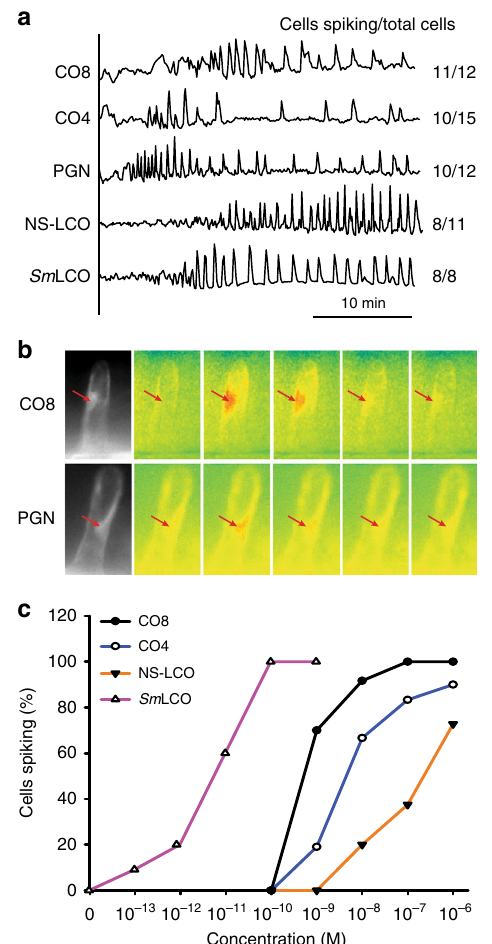
Fig. 1 COs and LCOs activate symbiotic calcium oscillations. a Representative traces of 10 − 8 M CO8, 10 − 8 M CO4, 0.8 mg/ml PGN, 10 − 8 M NS-LCO and 10 − 9 M Sm LCO-induced calcium oscillations in M. truncatula trichoblasts on lateral roots. The y -axis represents the ratio of YFP to CFP in arbitrary units. Numbers denote responsive cells relative to total cells analysed. b CO8 and PGN-induced calcium oscillations were restricted to the nuclear region (arrows indicate the location of the nucleus). Images were taken every fi ve seconds covering a single calcium transient. c Dose response curves for CO and LCO induction of calcium oscillations in M . truncatula lateral root trichoblasts. Sm LCO: sulphated LCO produced by S. meliloti . NS-LCO: non-sulphated LCO produced by R .